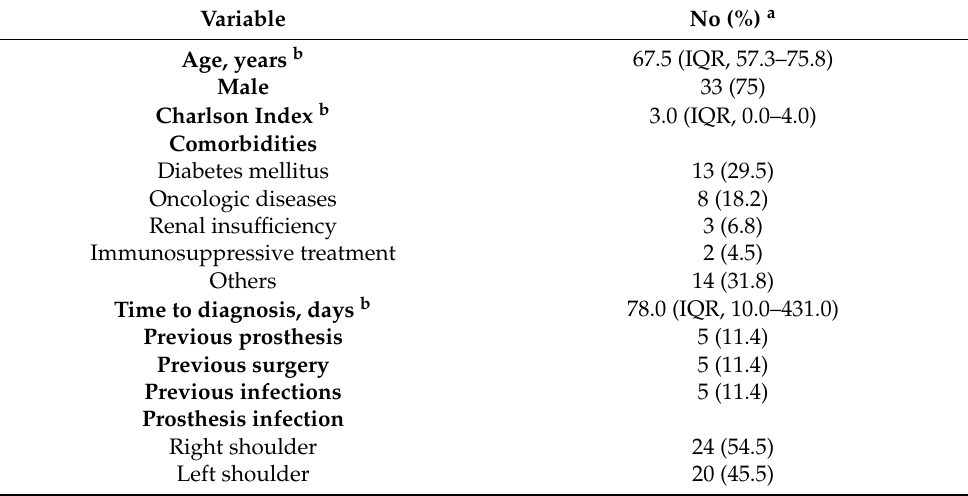
Table 1. Demographic, clinical, and laboratory characteristics of shoulder PJI due to C. acnes.